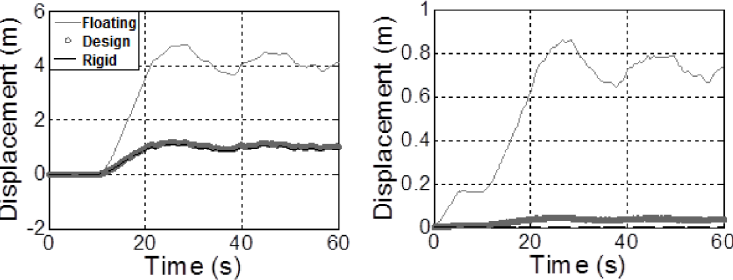
Fig. 8. Displacements in the direction normal to the TL at top (Node 19 – left) and bottom (Node 148 – right) of tower GTS 01, due to EPS wind load, for three support types considered